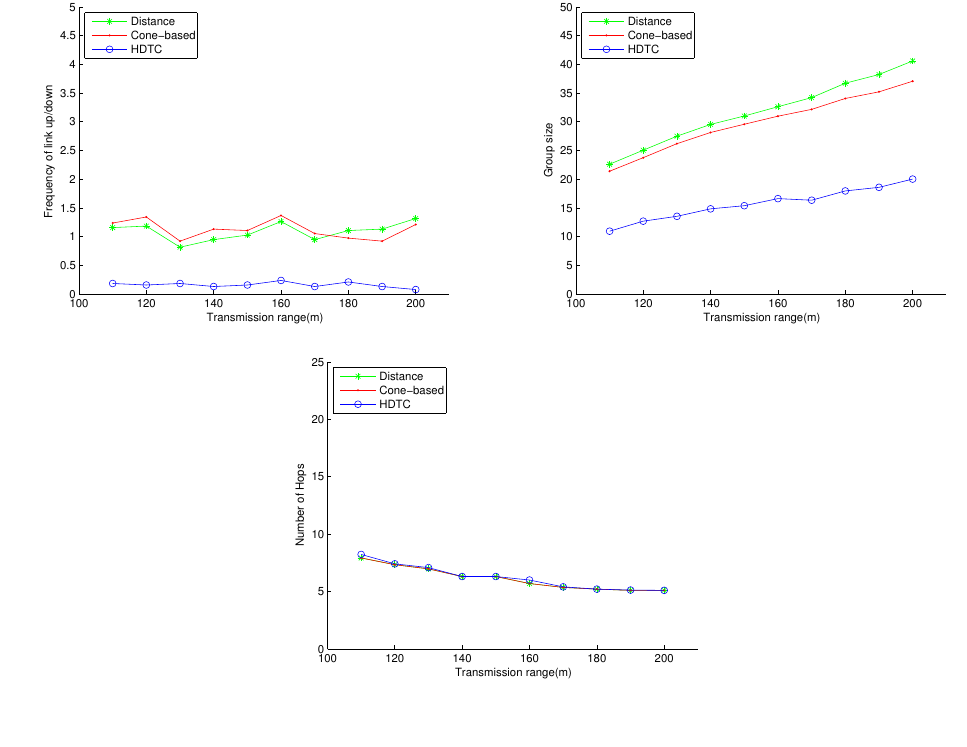
Figure 14. Scenario 2: The frequency of the link up/down, the group size and the number of hops with varying the connection